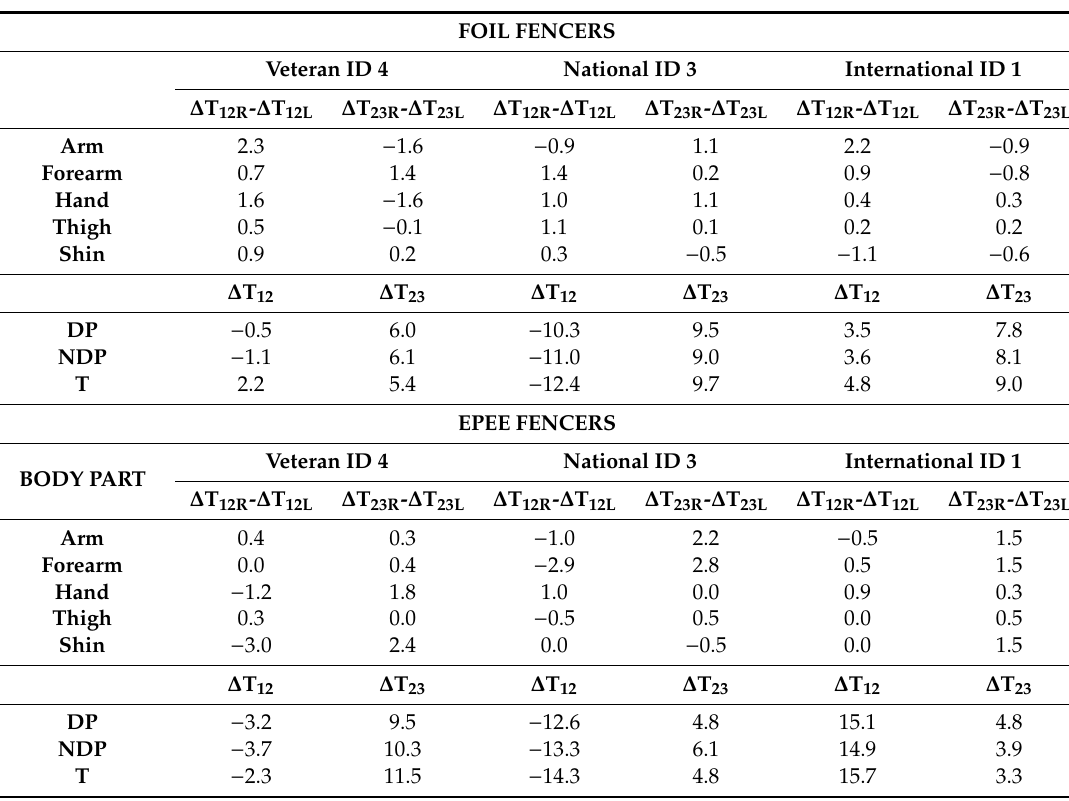
Table 6. Comparison between the right and the left part and between the dominant and non-dominant side of foil and epee fencers (DP: Dominant part; NDP: Non-Dominant Part, T: